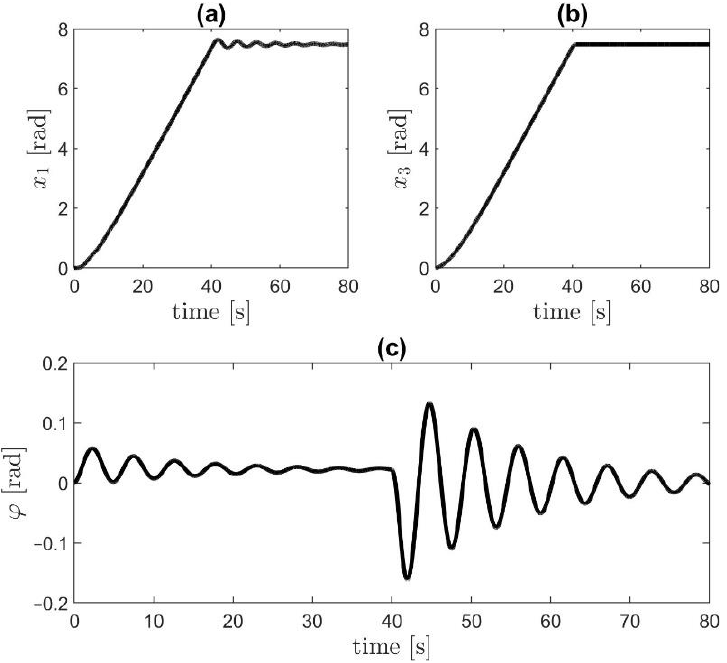
Figure 6. Open loop position control: ( a ) load position x 1 , ( b ) motor position x 2 , ( c ) torsion angle ϕ = x 3 − x 1 .